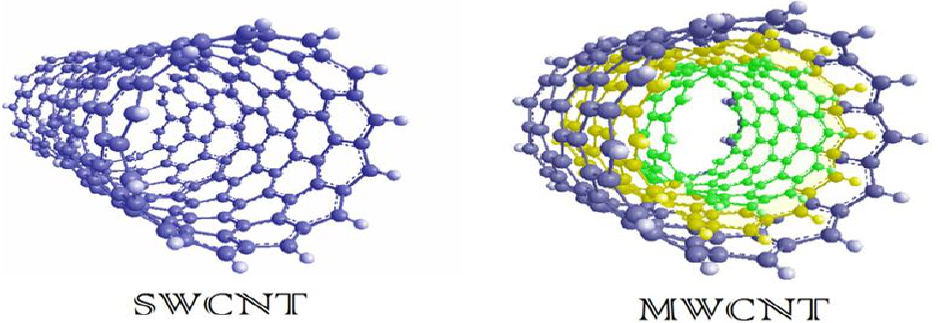
Figure 1. Structural morphology of CNT [50].